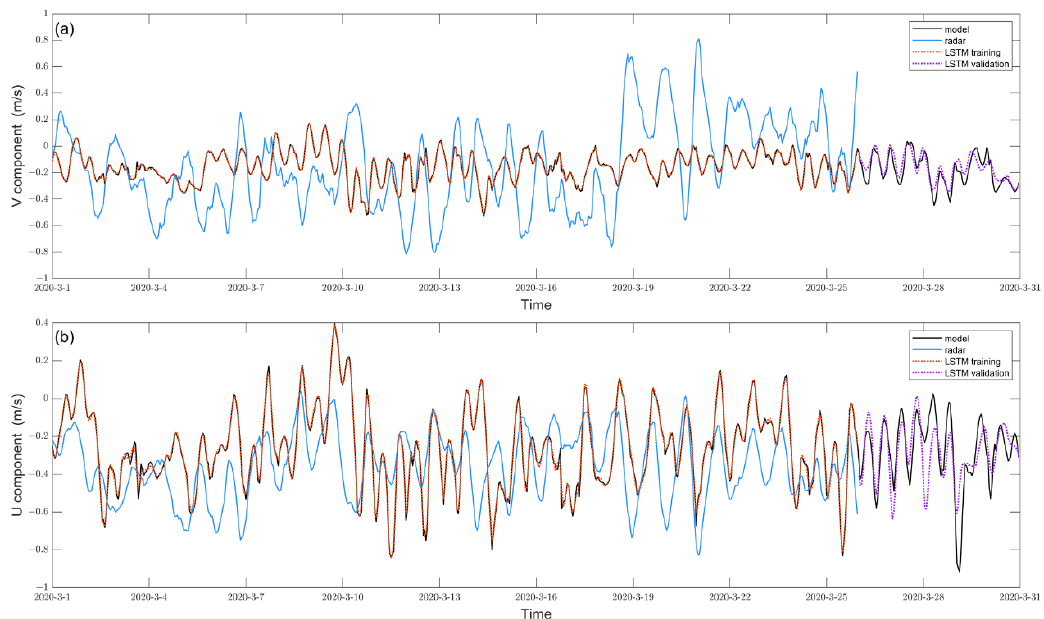
Figure 3. Line charts of point A current velocity for ( a ) the v component and ( b ) the u component. Solid black line: 1 – 30 March model data. Solid blue line: 1 – 25 March HF radar data. Dashed red line: 1 – 25 March LSTM training results. Solid purple line: 26 – 30 March LSTM validation results.